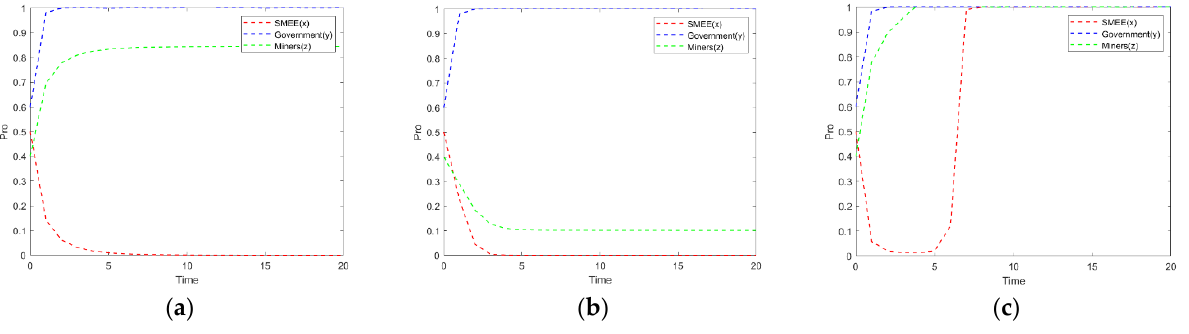
Figure 5. C a = 5.9 , strategy evolution process of the three game subjects under 3 emotional states of the miner. ( a ) 𝑟 1 = 𝑟 2 = 𝑟 3 = 1 ; ( b ) 𝑟 3 < 1 , 𝑟 1 = 𝑟 2 = 1 ; ( c ) 𝑟 3 > 1 , 𝑟 1 = 𝑟 2 = 1 .